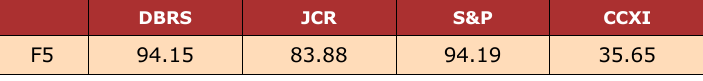
Table 16. Total Score of Four